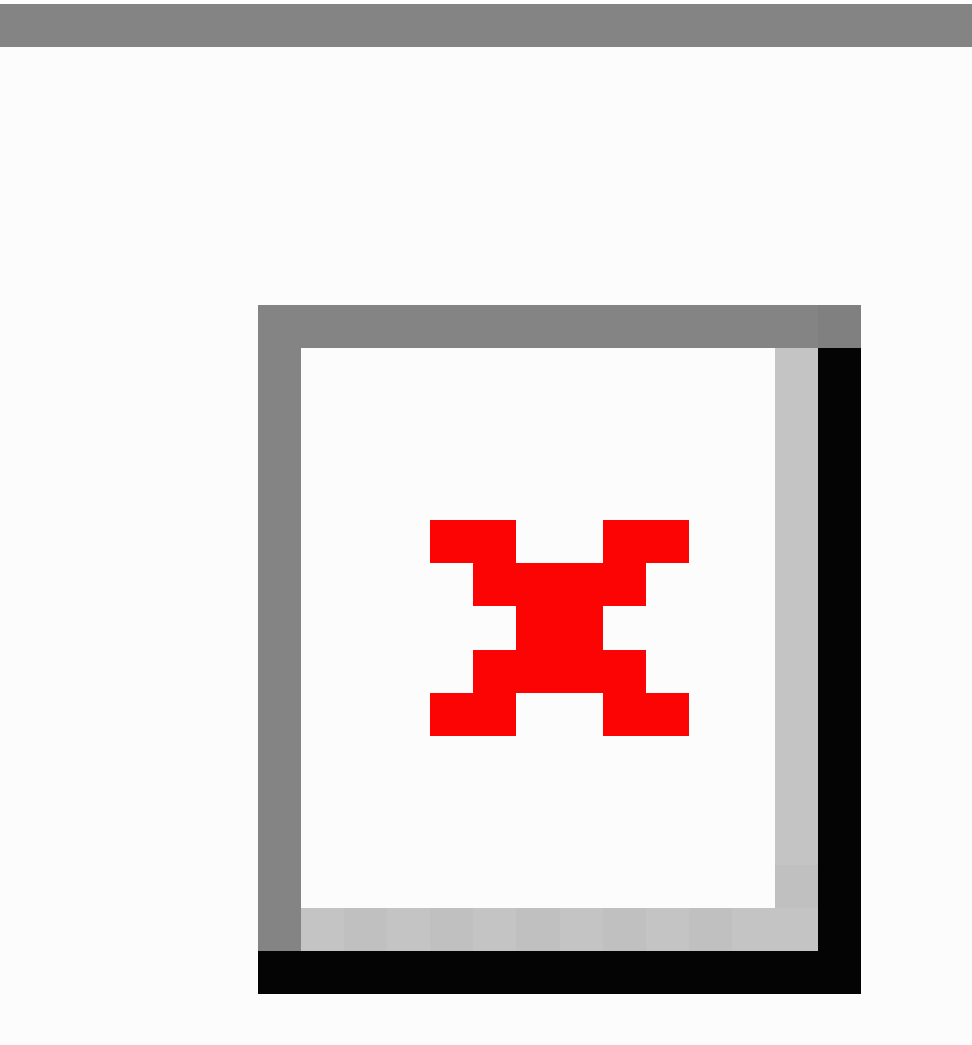
Figure 1. Technical architecture of the health coaching system supported with remote patient